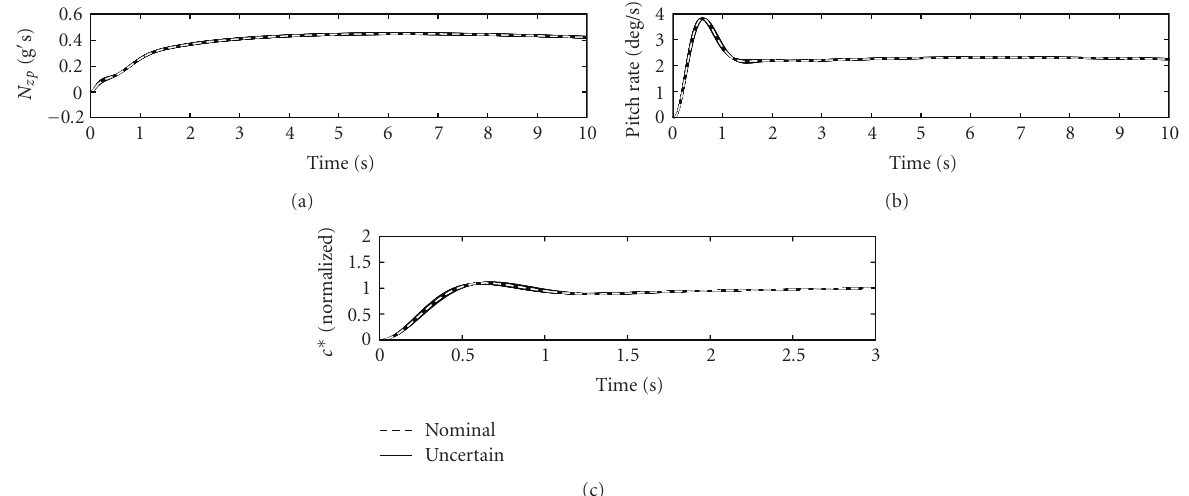
Figure 7: Monte carlo simulation for longitudinal dynamics.